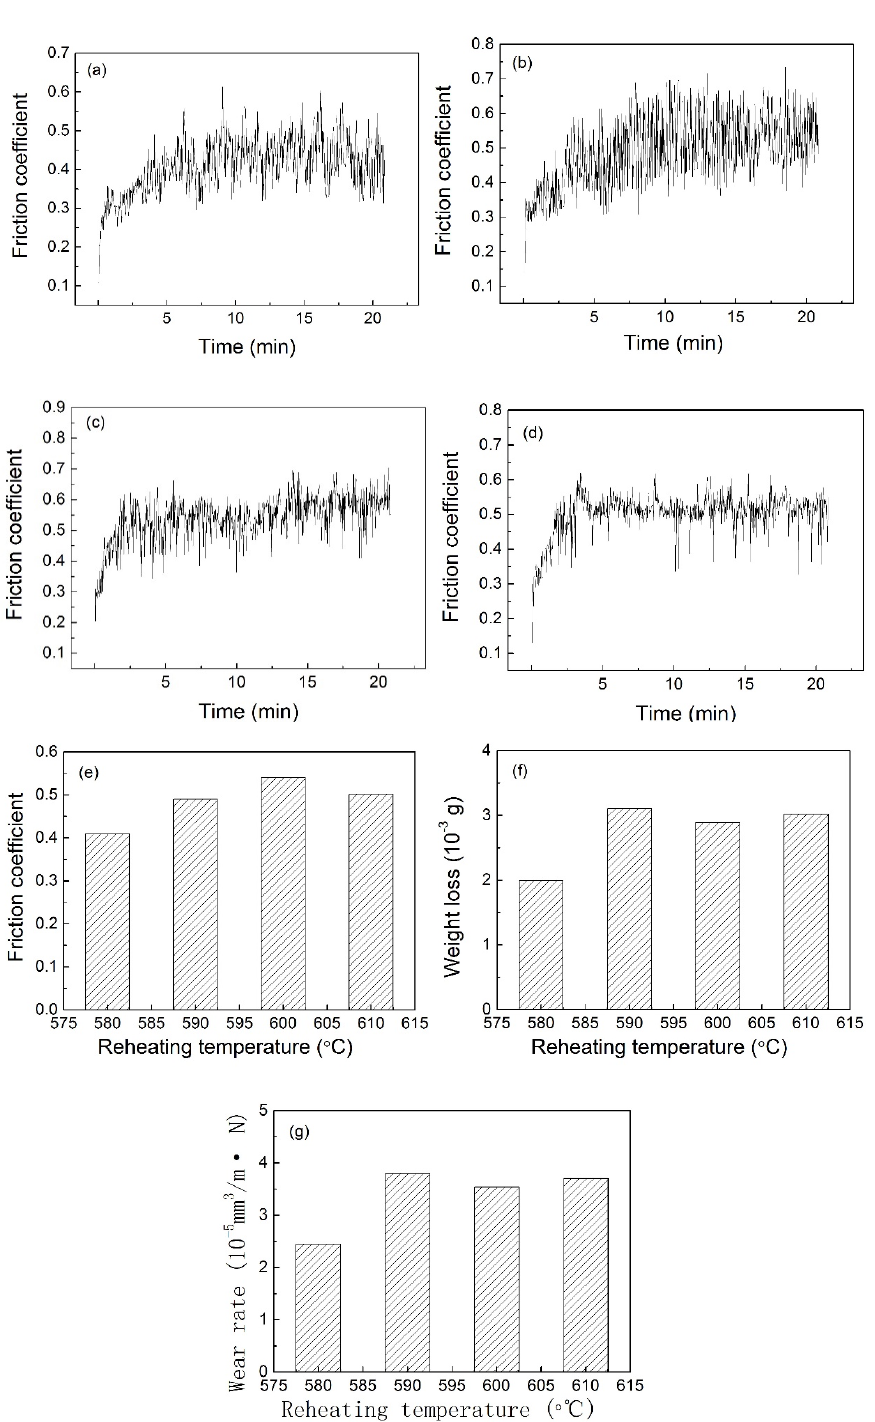
Figure 5. Friction coefficient, weight loss and wear rate of the thixoformed composite parts at different reheating temperatures: ( a ) friction coefficient at 580 °C, ( b ) friction coefficient at 590 °C, ( c ) friction coefficient at 600 °C, ( d ) friction coefficient at 610 °C, ( e ) average friction coefficient, ( f ) weight loss and ( g ) wear rate.